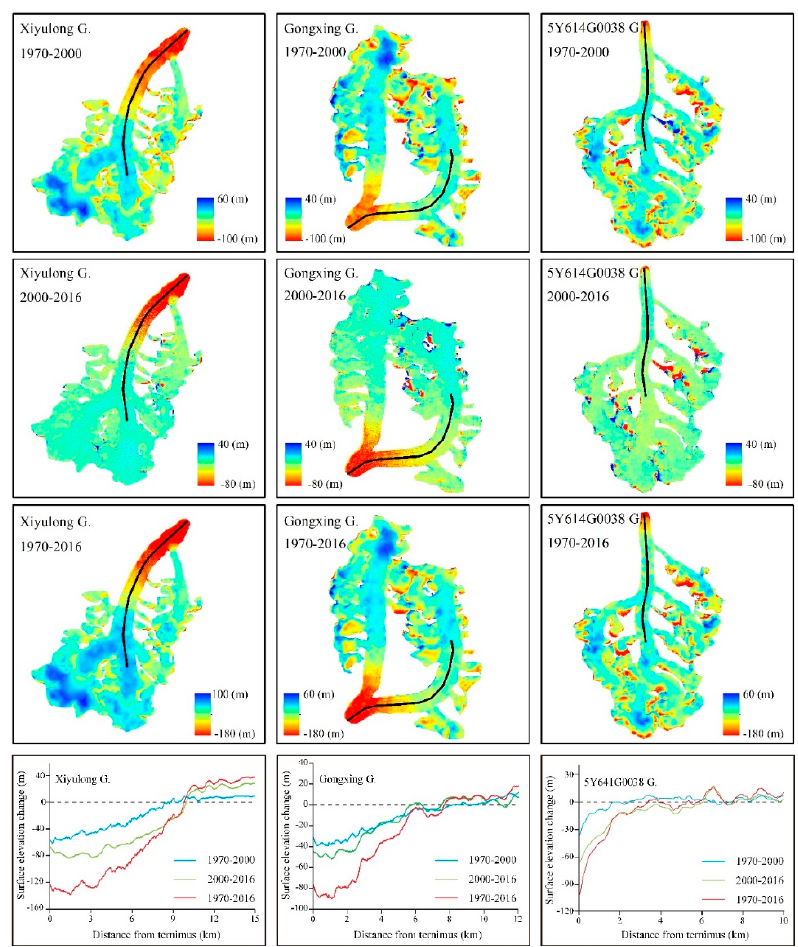
Figure 5. Changes in glacier surface elevation over time periods and their changes along the longitudinal section in the Xiyulong Glacier (abbreviated as Xiyulong G., the same below), Gongxing G. and 5Y614G0038 G. The locations of glaciers are shown in Figure 4 in black font.